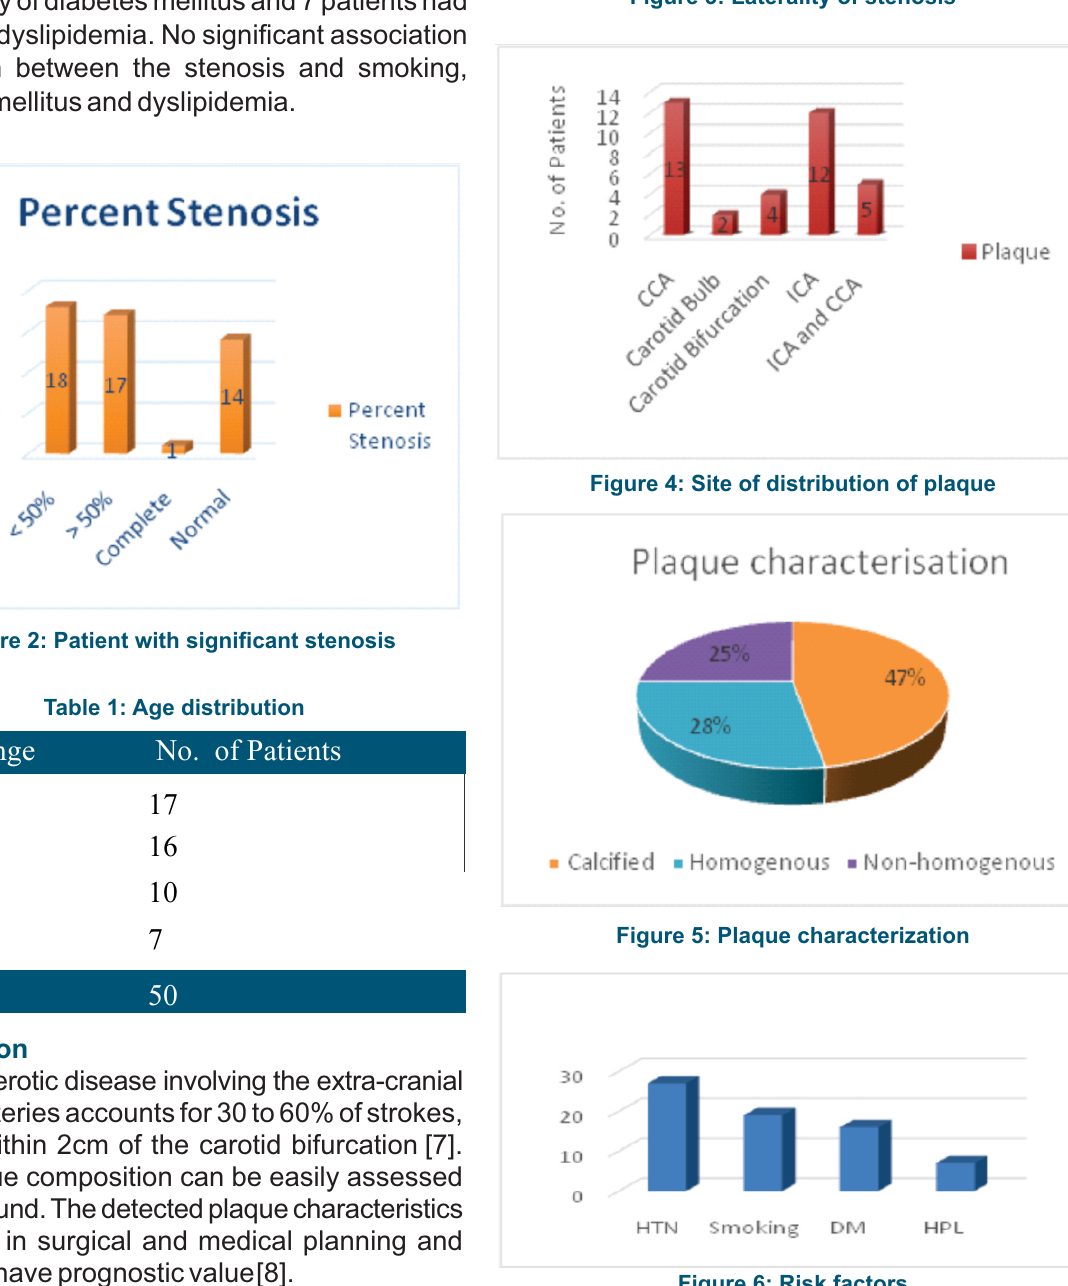
Figure 3: Laterality of stenosis